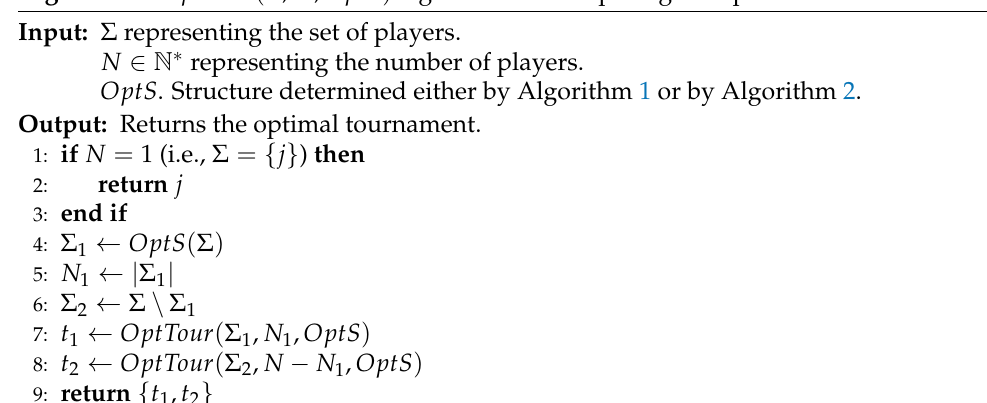
Algorithm 3 OptTour ( Σ , N , OptS ) algorithm for computing the optimal